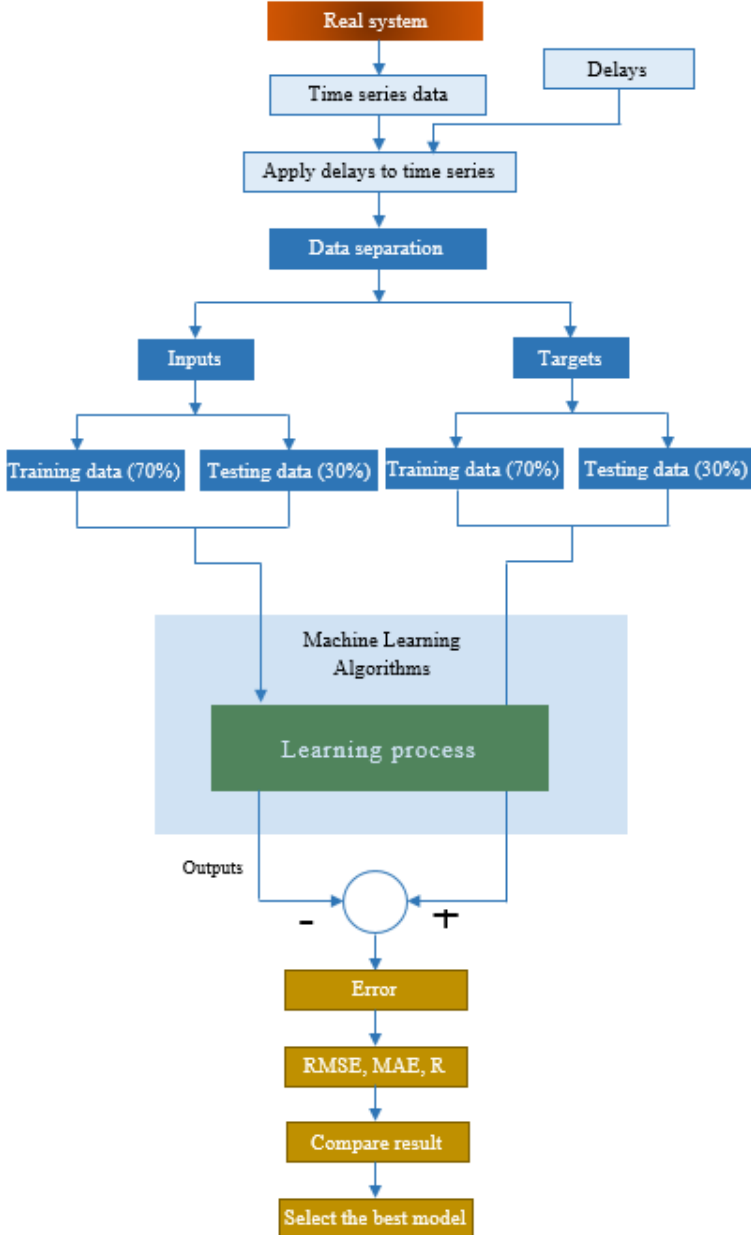
Fig. 6. The framework of demand forecasting using time series